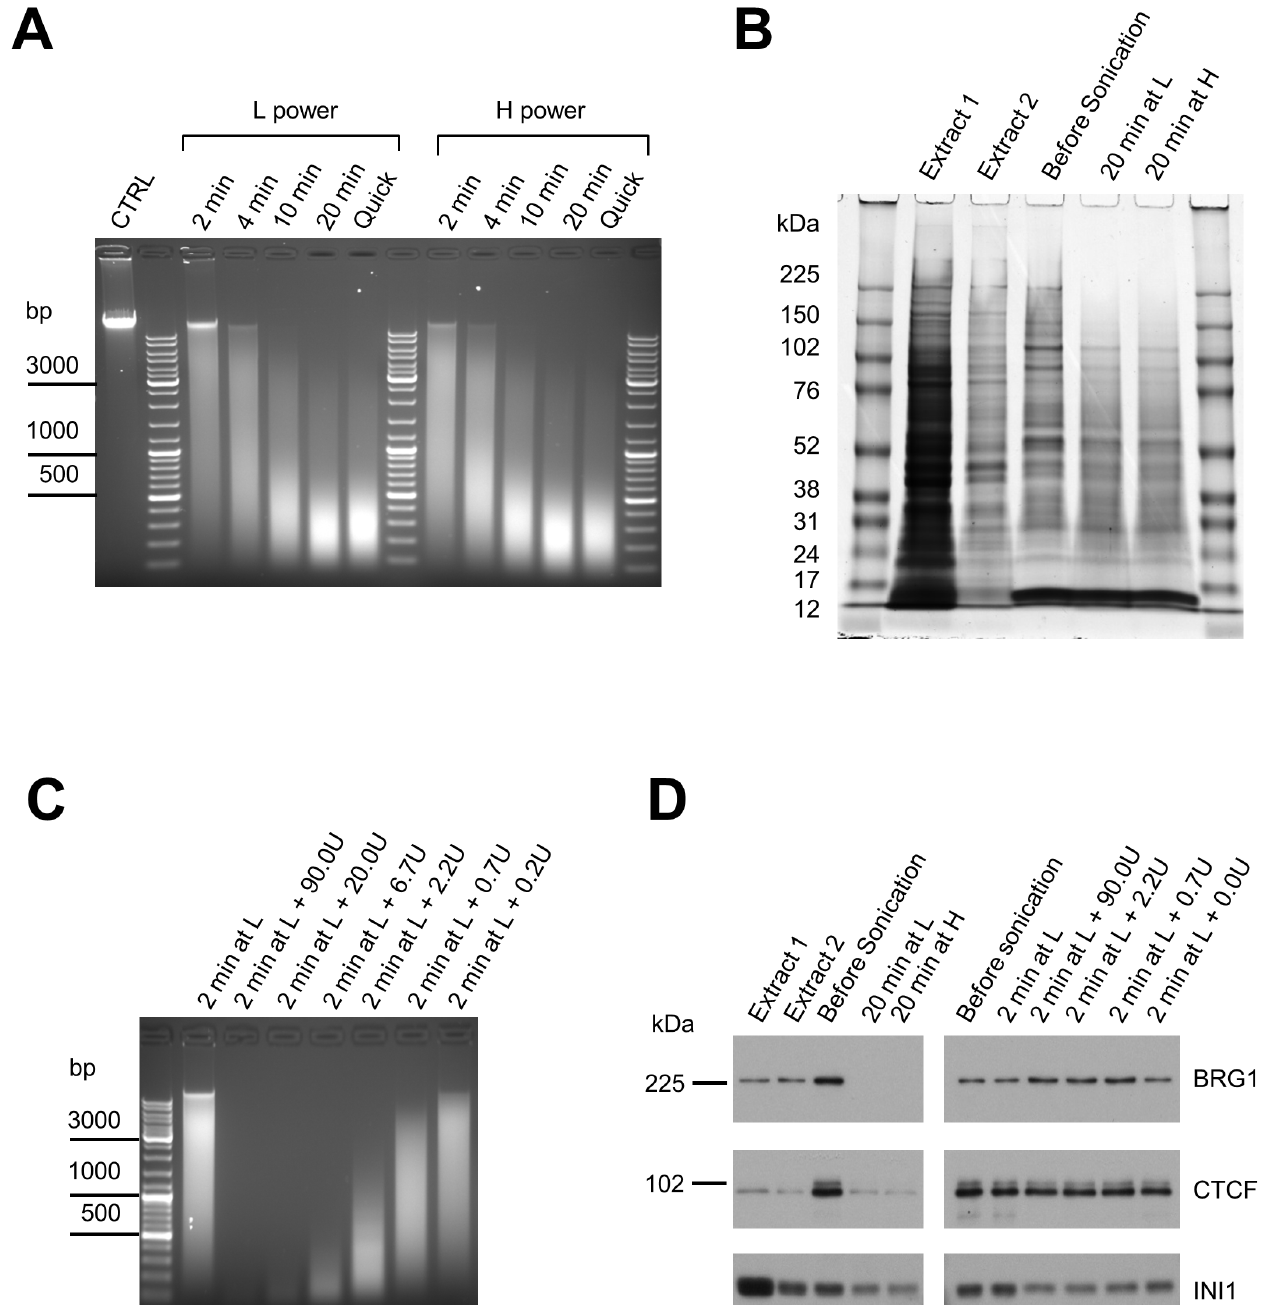
Fig 3. Comparison of chromatin fragmentation by ultrasound alone or in combination with benzonase digestion. (A) Comparison of sonication efficiency at the L and H power outputs over time. 500 μ L cell suspensions were loaded into position R1; positions R4, R7 and R11 were filled with tubes containing 500 μ L of water; other R-positions were left vacant. Sonication was carried out for various times (as indicated) in 1:4 ELB:H 2 O (0.1% SDS final concentration), 5 sec ON/5 sec OFF pulses, no rotation and no ice. Following sonication samples were reverse cross-linked overnight. DNA was purified from the resulting mixture using the Qiagen PCR clean-up kit and analysed on 1.1% agarose gel. The “ Quick ” lanes contain samples sonicated for 20 min and reverse cross-linked for 1 h at +60°C. (B) Coomassie Blue staining of protein fractions generated during the sonication time course shown in panel A. Note the absence of high molecular weight proteins after 20 min of ultrasound treatment. (C) Titration of benzonase (0.2U to 90U) to fragment chromatin solubilized by 2 min L-power sonication. Following the digest, samples were reverse cross-linked overnight. DNA was purified from the resulting mixture using the Qiagen PCR clean-up kit and analysed on 1.1% agarose gel. See Material and Methods section for detailed reaction conditions. (D) Combination of brief sonication (2 min at L-power) and benzonase digestion (0.7U to 90U) preserves the integrity of large proteins.